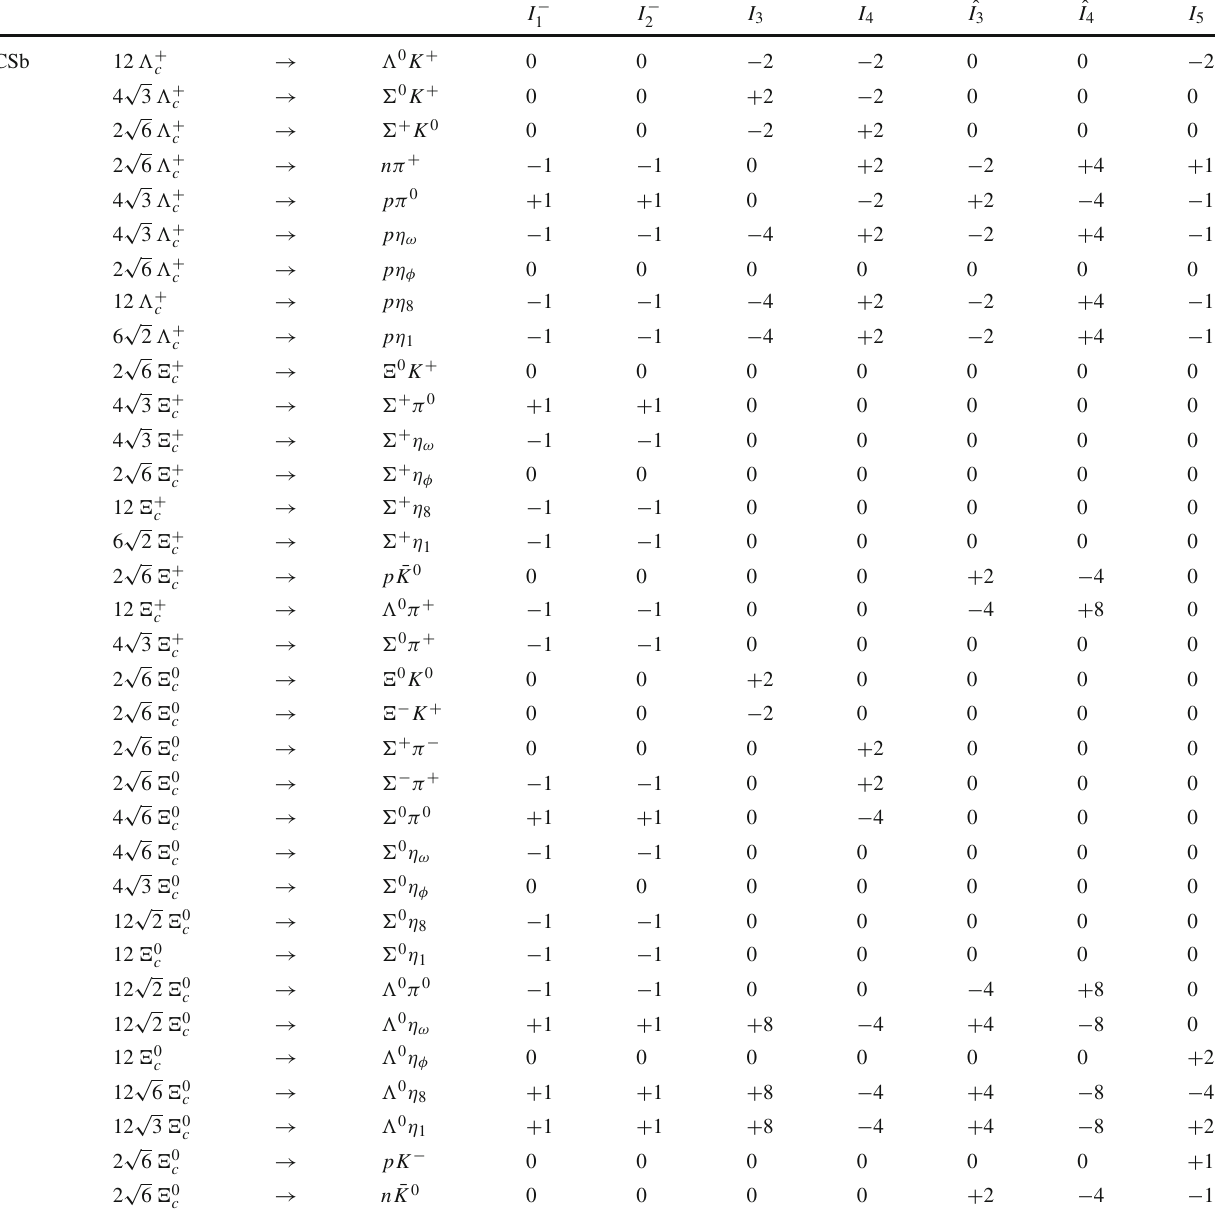
Table 5 Values of the seven topological tensor invariants for the SCS antitriplet charm baryon decays B c ( 3 ) → B ( 8 ) + M ( 8 , 1 ) induced by the flavor transition ( c → d ; d → u )